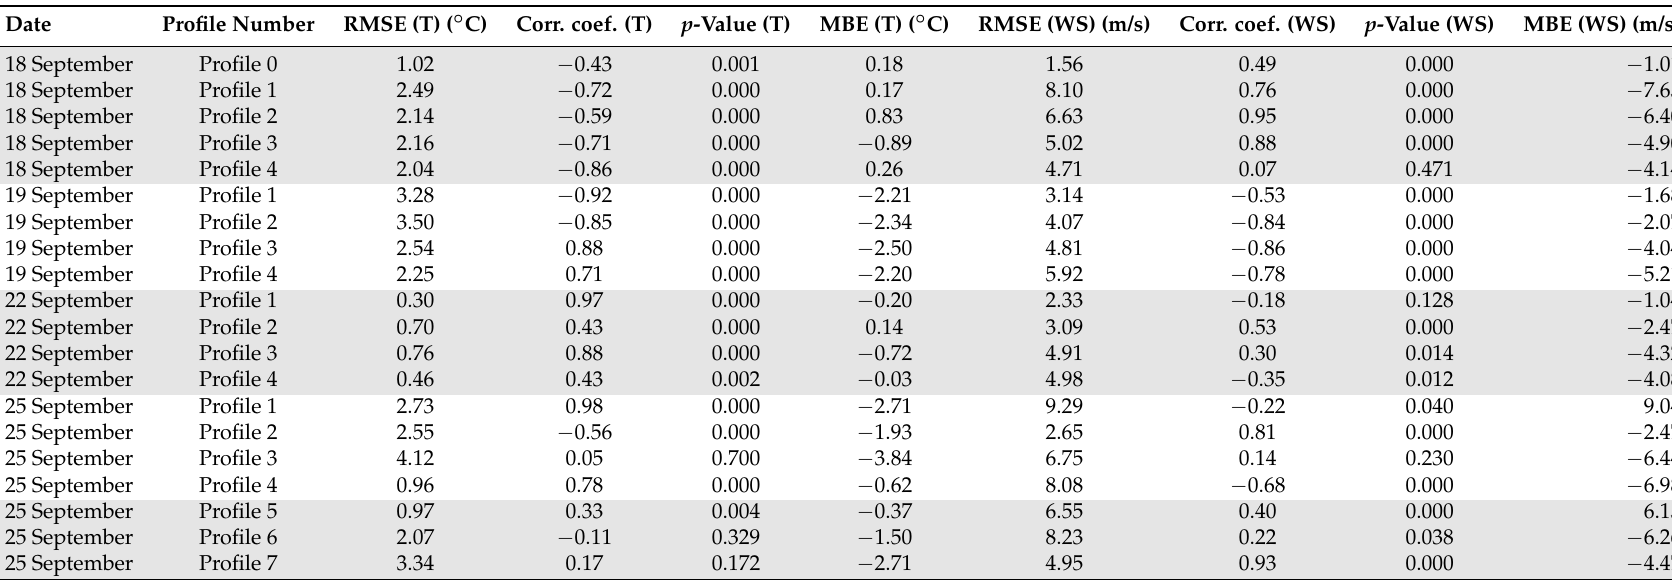
Table 5. Statistics for the comparison of AMPS results and UAS Aerosonde profiles in the upper layer of the atmosphere (1000–1500 m). T—temperature, WS—wind